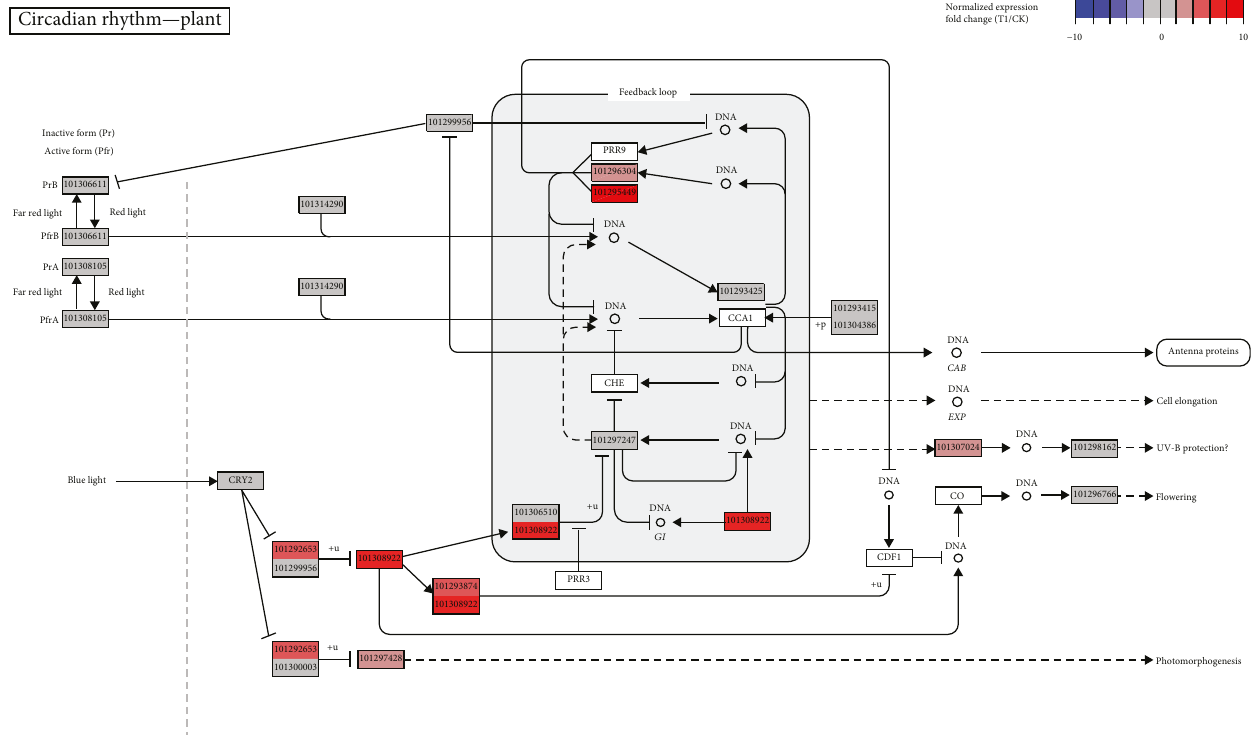
Figure 5: Circadian clock pathway mapped with relative expression levels (T1 vs . CK). Gene ID of F. vesca is indicated at the corresponding gene node if there